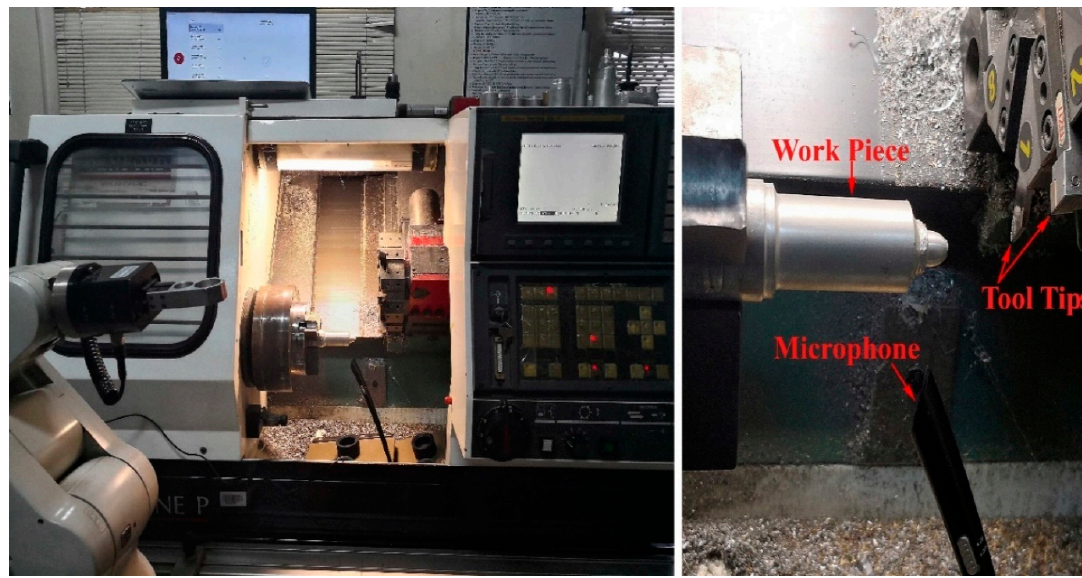
Figure 7. ( Left ) View of the whole experimental setup for computer numeric control (CNC) turning operation and data acquisition. ( Right ) Zoomed view of the setup illustrating the details of